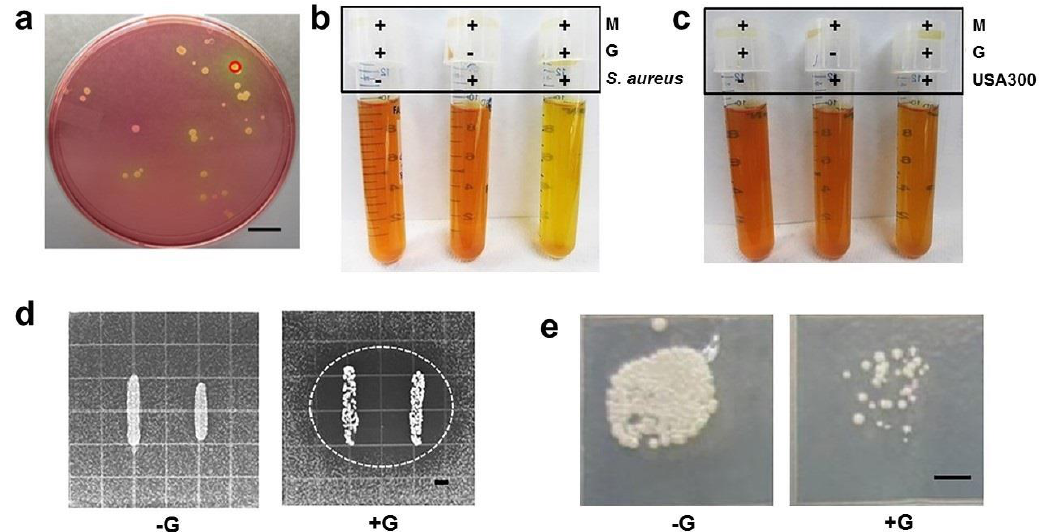
Figure 1. Differential activities of glycerol fermentation of commensal Staphylococcus aureus and USA300 and bacterial interference in the via glycerol fermentation. ( a ) A colony with a yellow zone (circle) was identified as commensal S. aureus by 16S rRNA sequencing; ( b ) isolated commensal S. aureus or ( c ) USA300 was incubated in rich media (M) with/without glycerol (G) for ten days. Rich media plus glycerol without S. aureus or USA300 were included as a control; ( d ) an overlay assay reveals a zone (circled) of inhibition in USA300 growth when commensal S. aureus and USA300 were grown with glycerol (+G). No inhibition zone developed when two bacteria were grown without glycerol ( − G); ( e ) commensal S. aureus was co-cultured with USA300 in the presence (+G) or absence ( − G) of glycerol. After a 4-day culture, media were spotted on benzylpenicillin-containing tryptic soy broth (TSB) plates overnight. Bars = 0.5 cm.